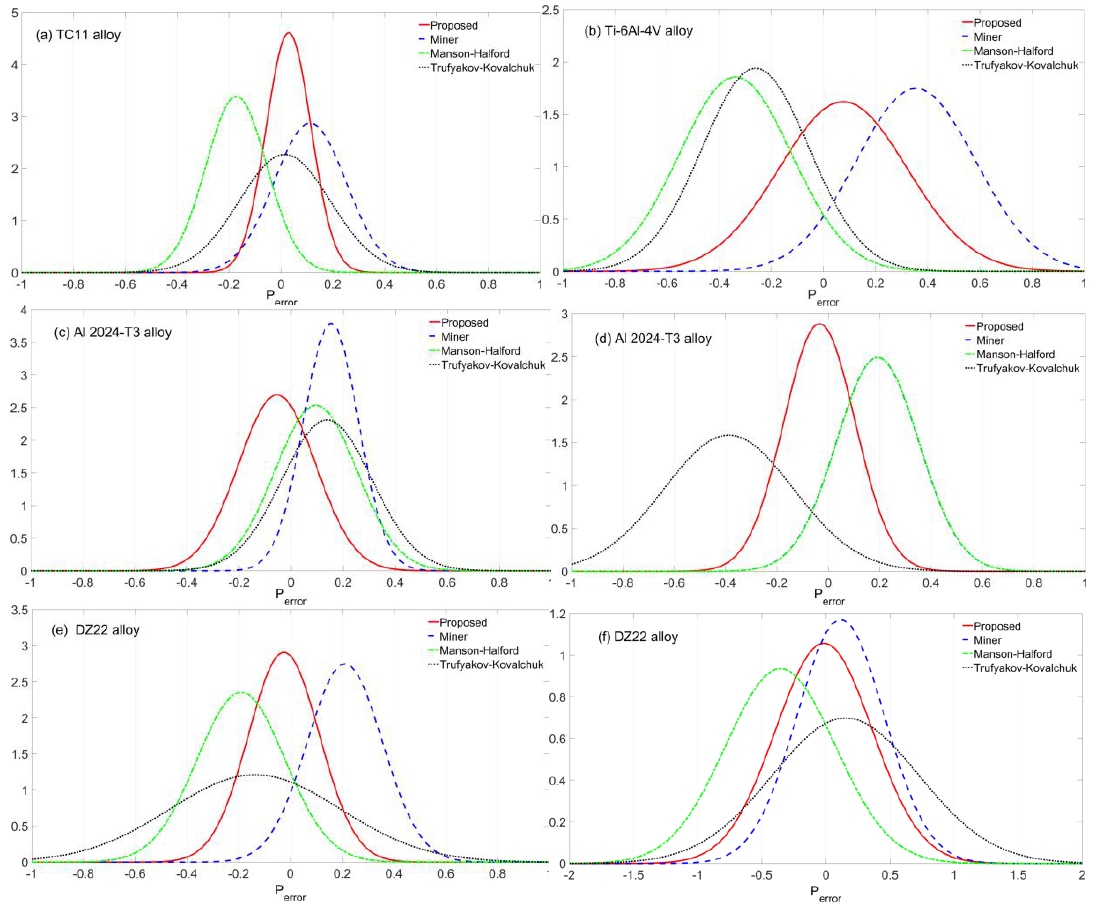
Figure 6. Model prediction errors of ( a ) TC11; ( b ) Ti-6Al-4V; ( c ) Al 2024-T3 for different α ; ( d ) Al 2024-T3 for different n ; ( e ) DZ22 alloy for different temperatures and ( f ) DZ22 alloy for different ∆ σ L